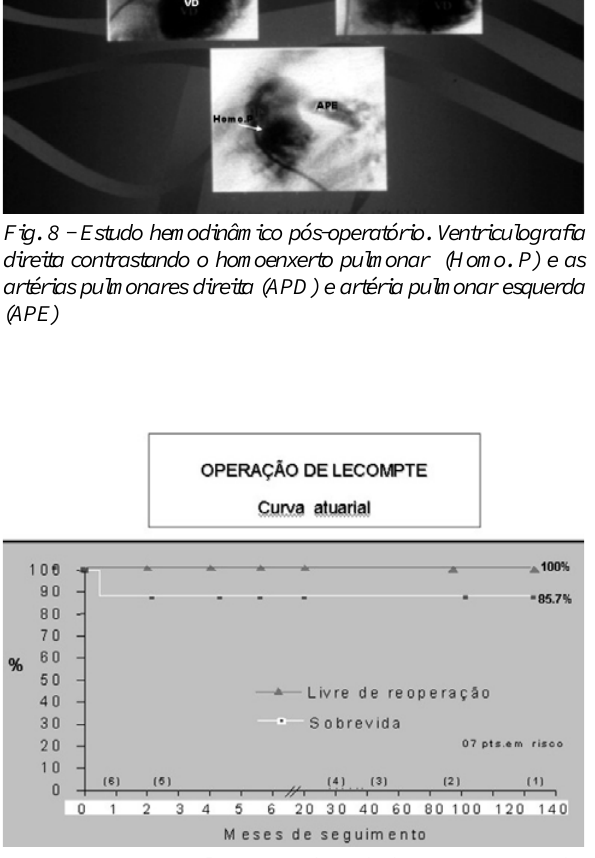
Fig. 9 - A curva atuarial mostra a sobrevida dos pacientes operados (85,7%) e os pacientes livres de reoperações (100%), num